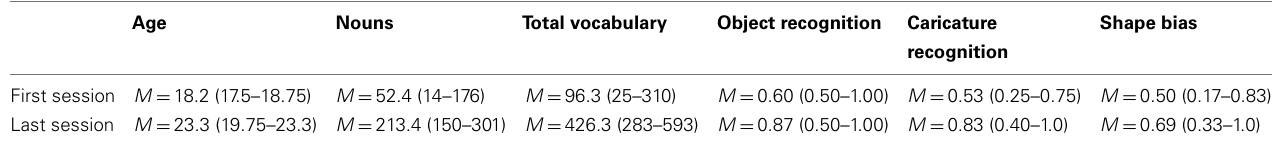
Table 3 |The mean ages, noun vocabulary size, total vocabulary size, and mean performance in the three tasks for children at the first session and the last session for the 6-month longitudinal sample of Experiment